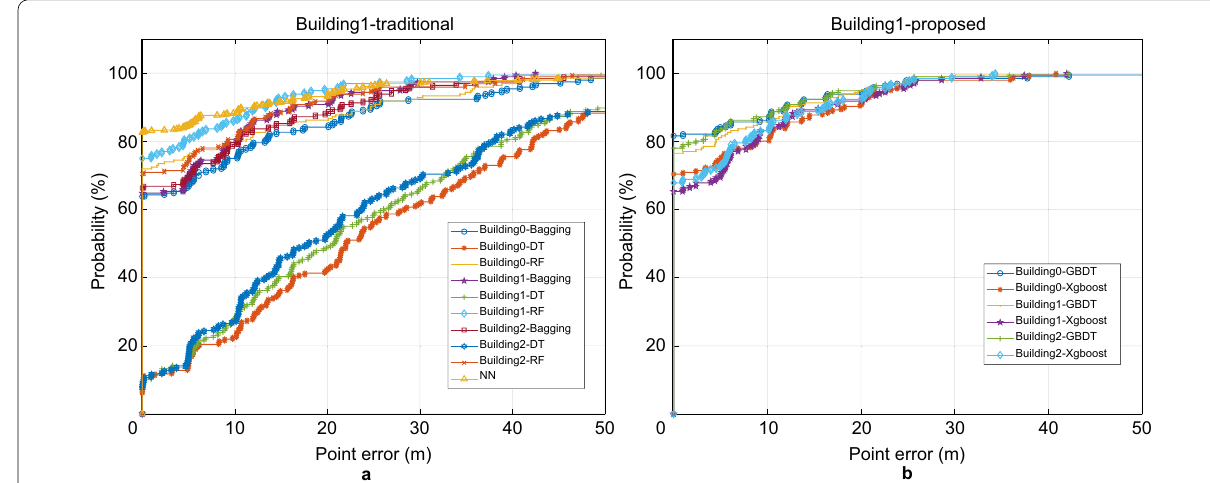
Fig. 8 The CDFs of Building1 using traditional methods and the proposed method